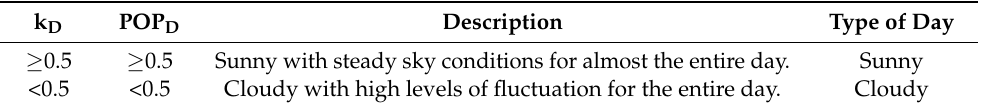
Table 8. Classification parameters of daily irradiance using k D and POP D indexes.